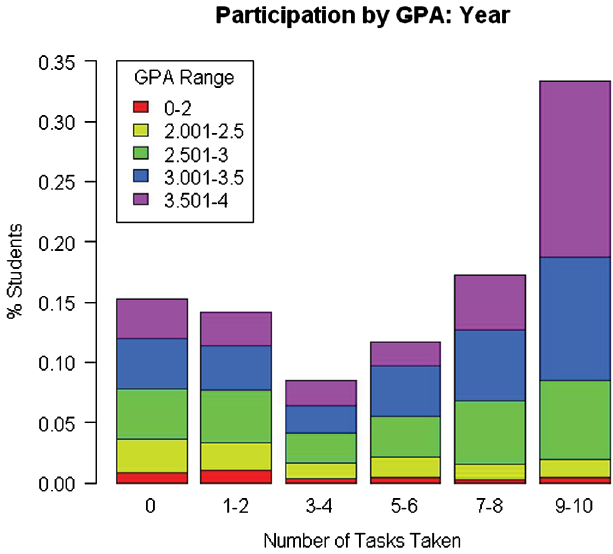
FIG. 1 (color online). Student participation is bimodal, with 40% of students completing seven or more tasks, and (cid:3) 30% of students completing less than